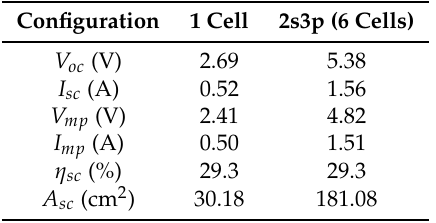
Table 5. AZURSPACE 3G30A datasheet data 1